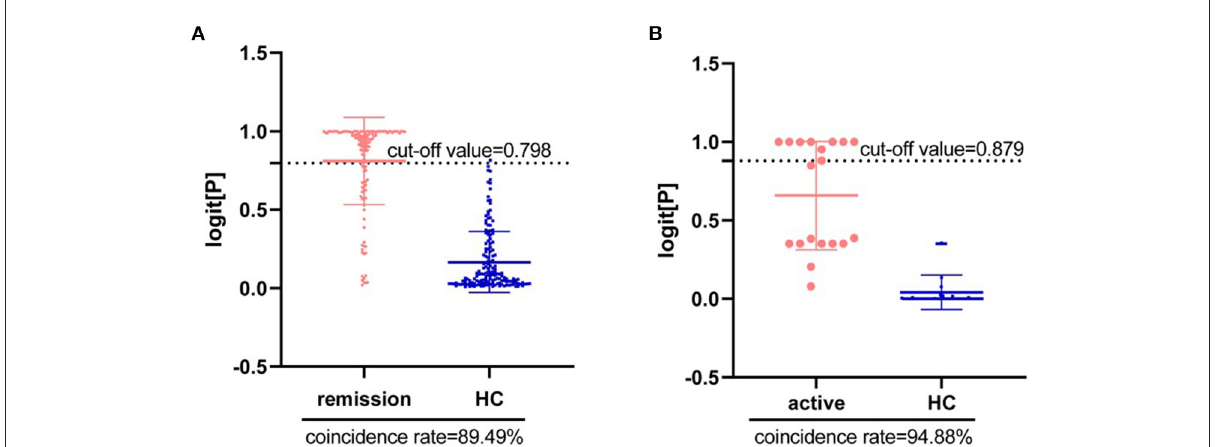
FIGURE7 Diagnosis of disease activity in Crohn’s Disease using Deoxycholic acid and Palmitic amide. (A) Diagnostic coincidence rate for the comparison between remission CD vs. HCs. (B) Diagnostic coincidence rate for the comparison between active CD vs. HCs. The vertical axis is the predicted probability. The horizontal axis represents the